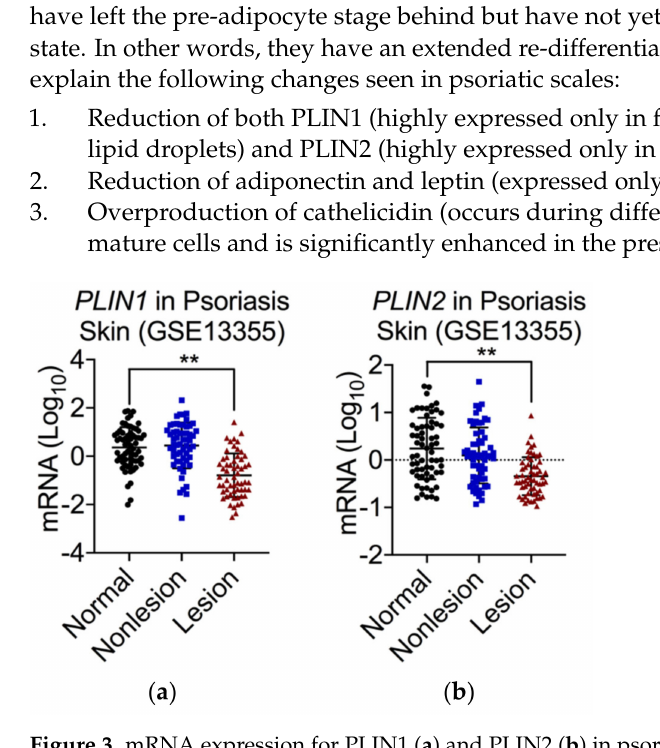
Figure 3. mRNA expression for PLIN1 ( a ) and PLIN2 ( b ) in psoriatic scales compared to normal and non-lesional skin. The materials and methods were described in [4], ** p <